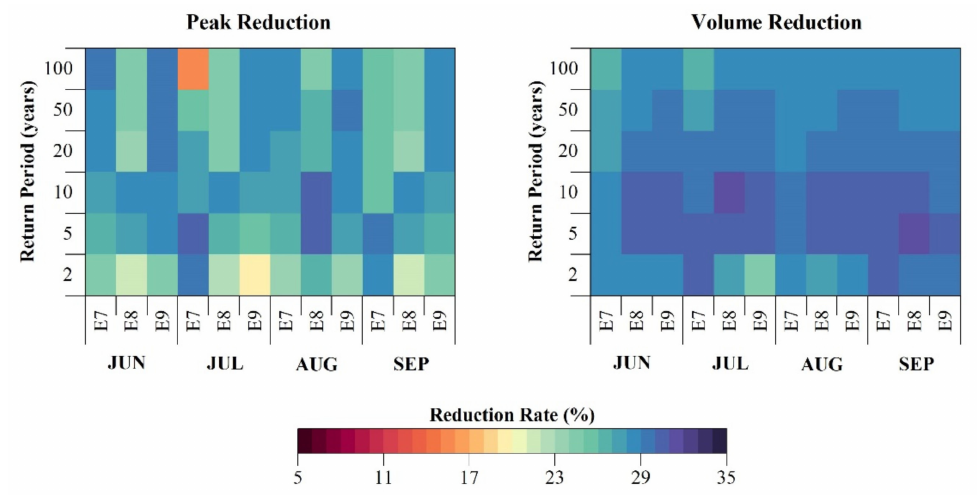
Figure 13. Effect of multi peak flood control